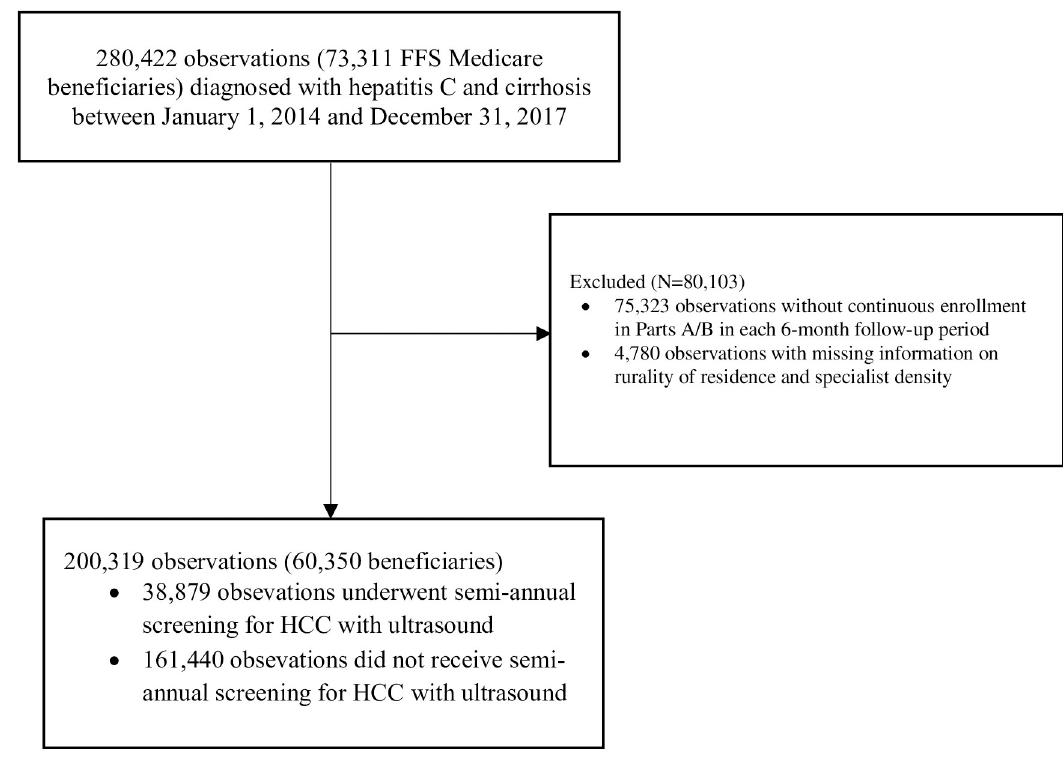
Fig 2. Study sample selection for routine screening for hepatocellular carcinoma screening among patients with hepatitis C and cirrhosis. Abbreviations: FFS, fee-for-service. Note: Follow-up period is defined as every 6-month period from the index date—the date of the first cirrhosis claim between 2014 and